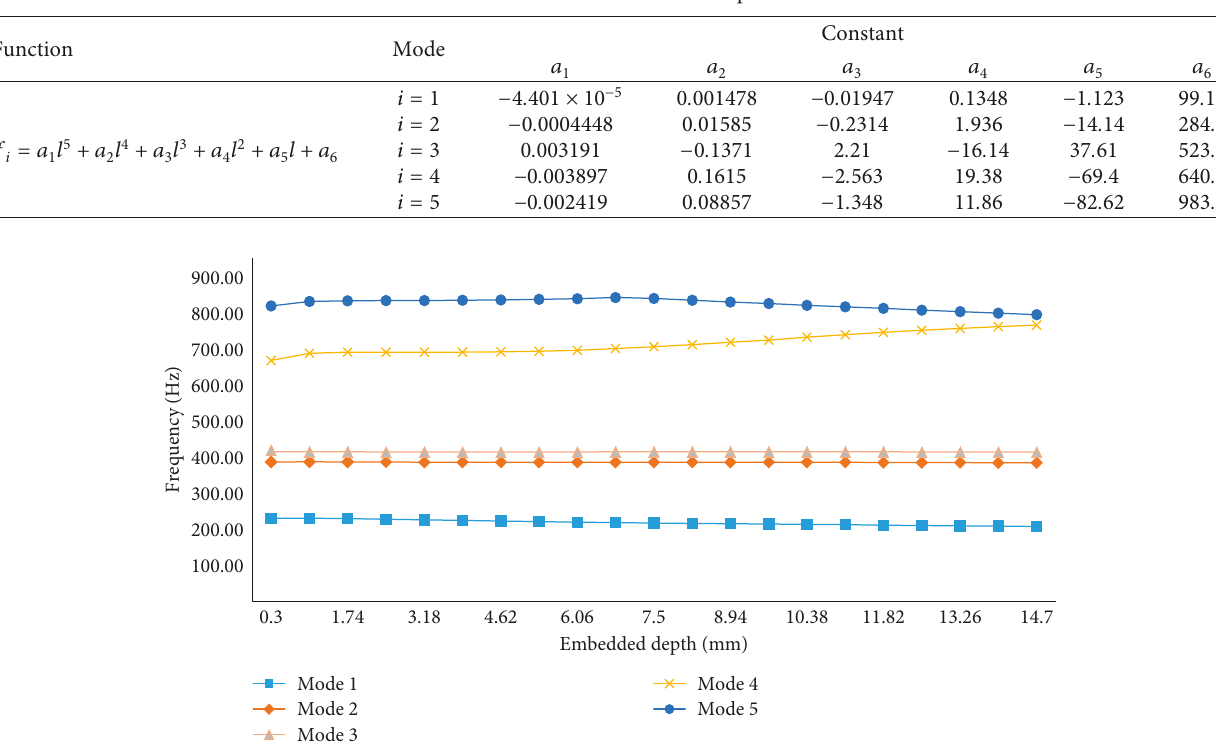
Figure 14: Relationship between frequency and embedded depth. Table 5: Function